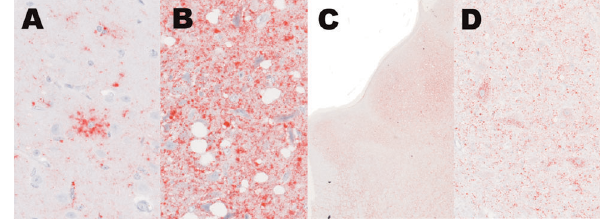
Figure 4. Patterns of immunoreactivity (red) in the brain vary depending on region. Staining patterns observed included ( A ) intraglial, stellate in the cerebrum, ( B ) coalescing throughout the neuropil of the hippocampus, and ( C, D ) intraneuronal in the perikarya of hypoglossal nucleus. Original magnification 40 6 , 40 6 , 2 6 , and 20 6 , respectively.